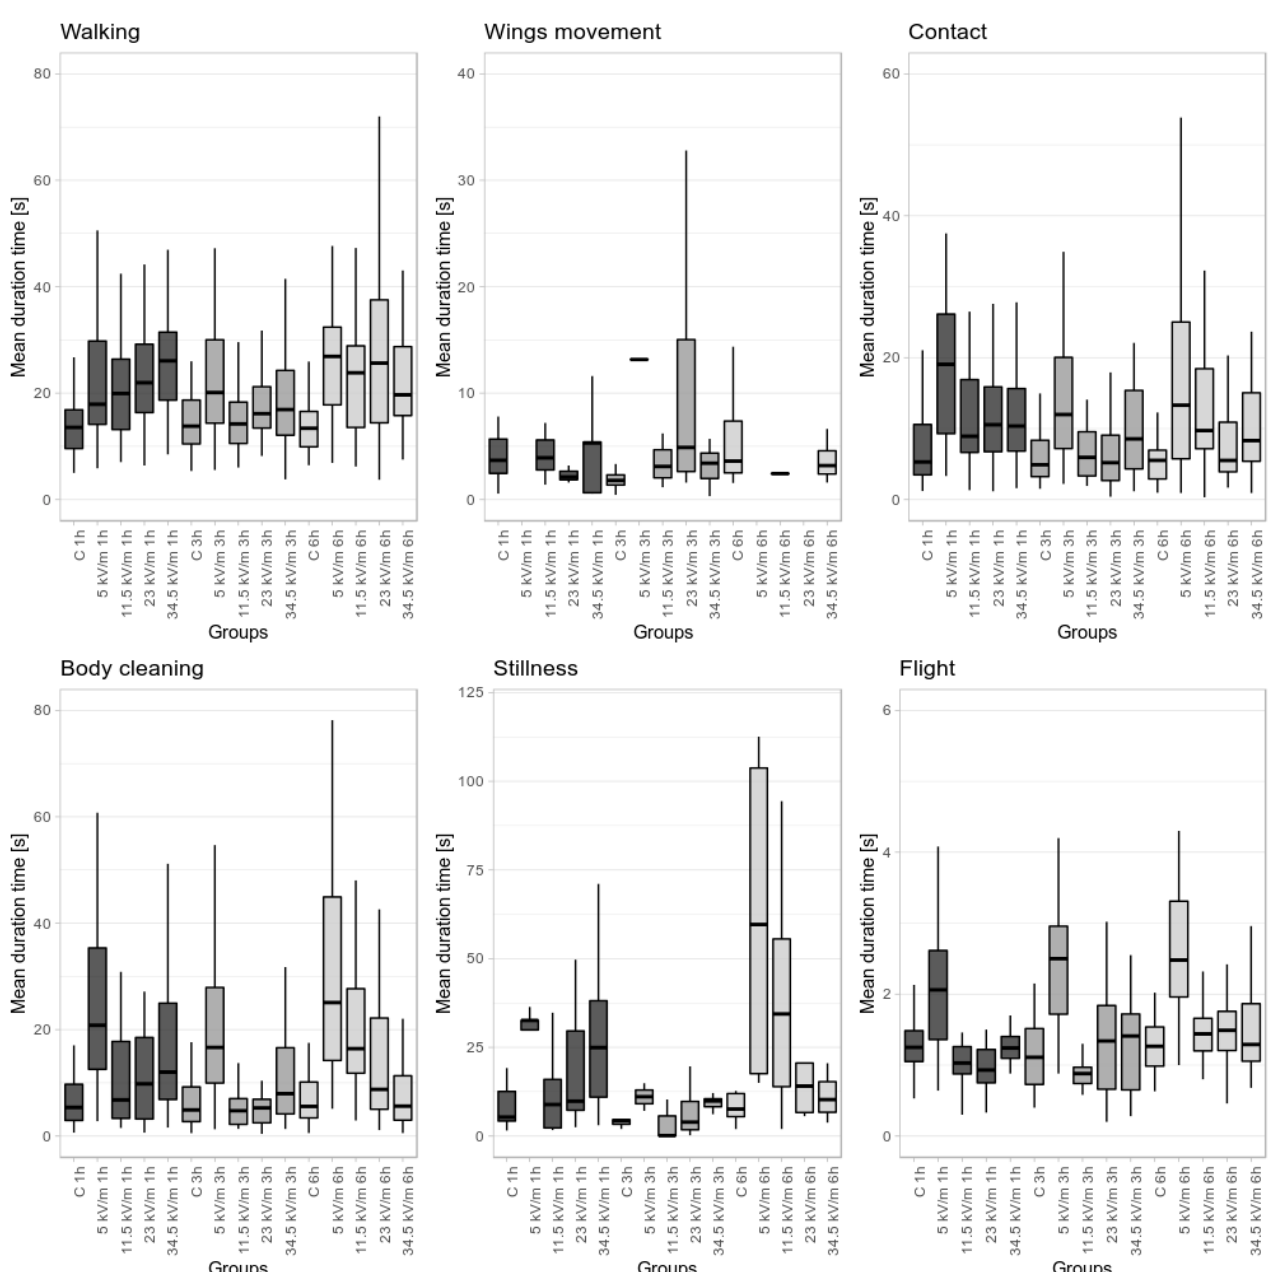
Figure 2. Comparison of the mean duration as a function of exposition time and E-field intensity in and between all groups. The median values are marked as horizontal lines. The lower and upper whiskers denote the minimum and maximum values, respectively.